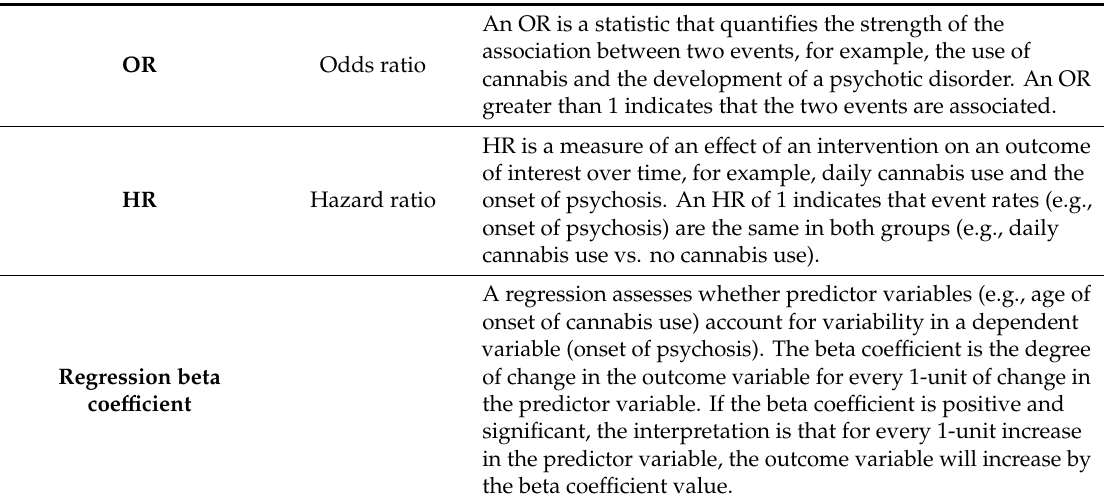
Table 1. Explanation of statistical outcome